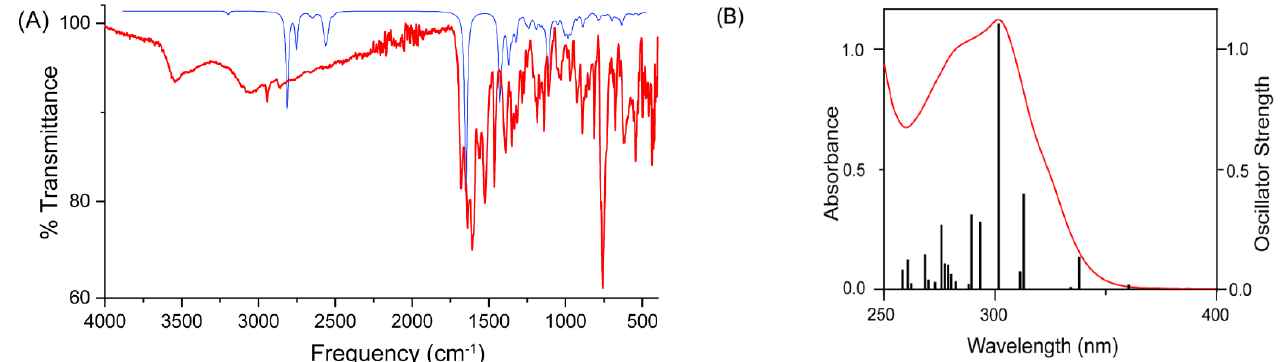
Figure 5. ( A ) Experimental (red) and DFT simulated (blue) FTIR spectra of compound 4 . ( B ) Absorption spectra (curved line, left axis) of compound and oscillator strengths (vertical line, right axis) obtained from TD-DFT